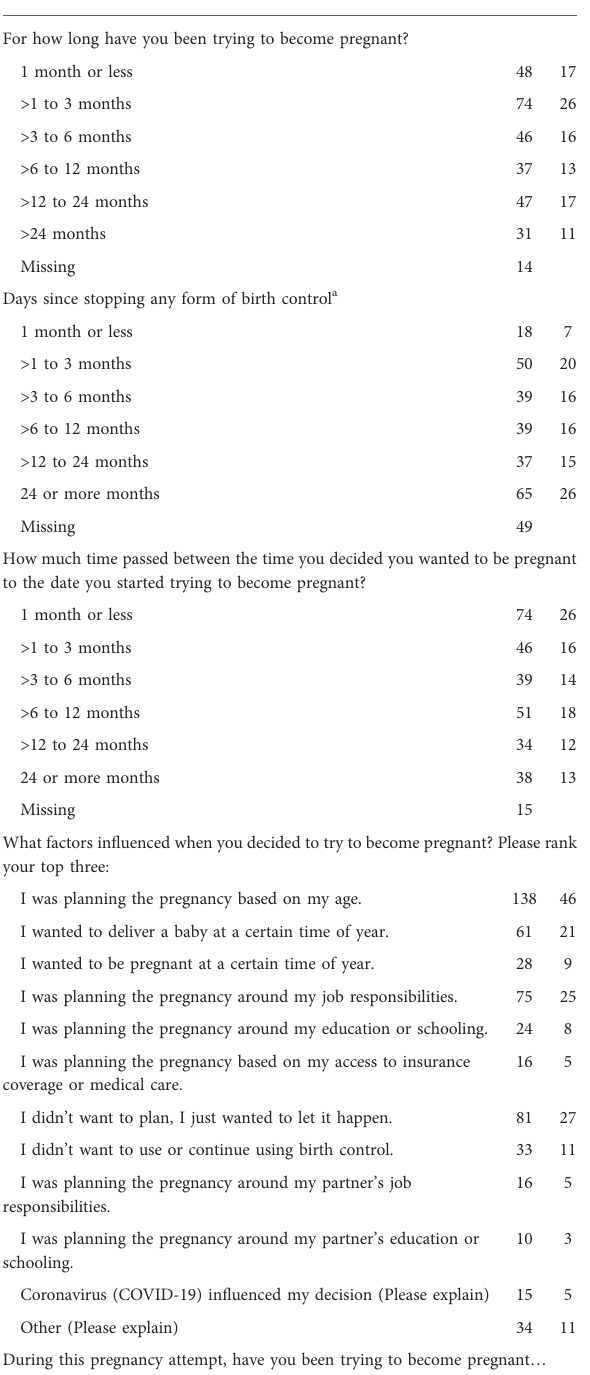
TABLE 3 Characteristics of the current pregnancy attempt among those who were trying to conceive ( n